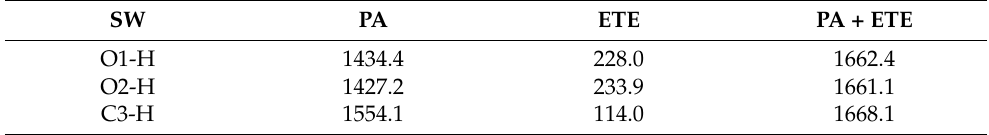
Table 6. Lowest proton affinities (PAs) and electron transfer enthalpies (ETE) in kJ/mol for Santowhite (SW) calculated at the M06-2X/6-311++G(2d,2p) level of theory in gas phase. SW PA ETE PA + ETE O1-H 1434.4 228.0 1662.4 O2-H 1427.2 233.9 1661.1 C3-H 1554.1 114.0 1668.1